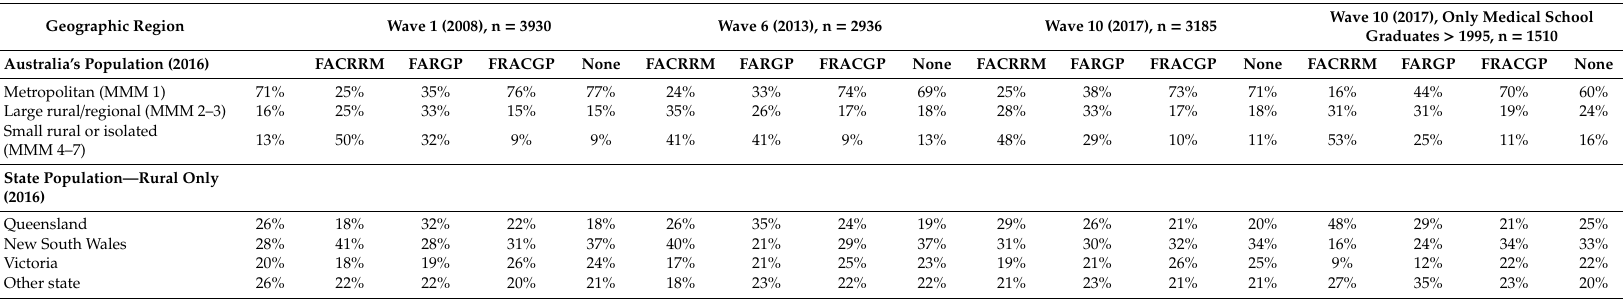
Table 4. Geographic distribution of the Medicine in Australia: Balancing Employment and Life (MABEL) study. GP participants by fellowship group. Geographic